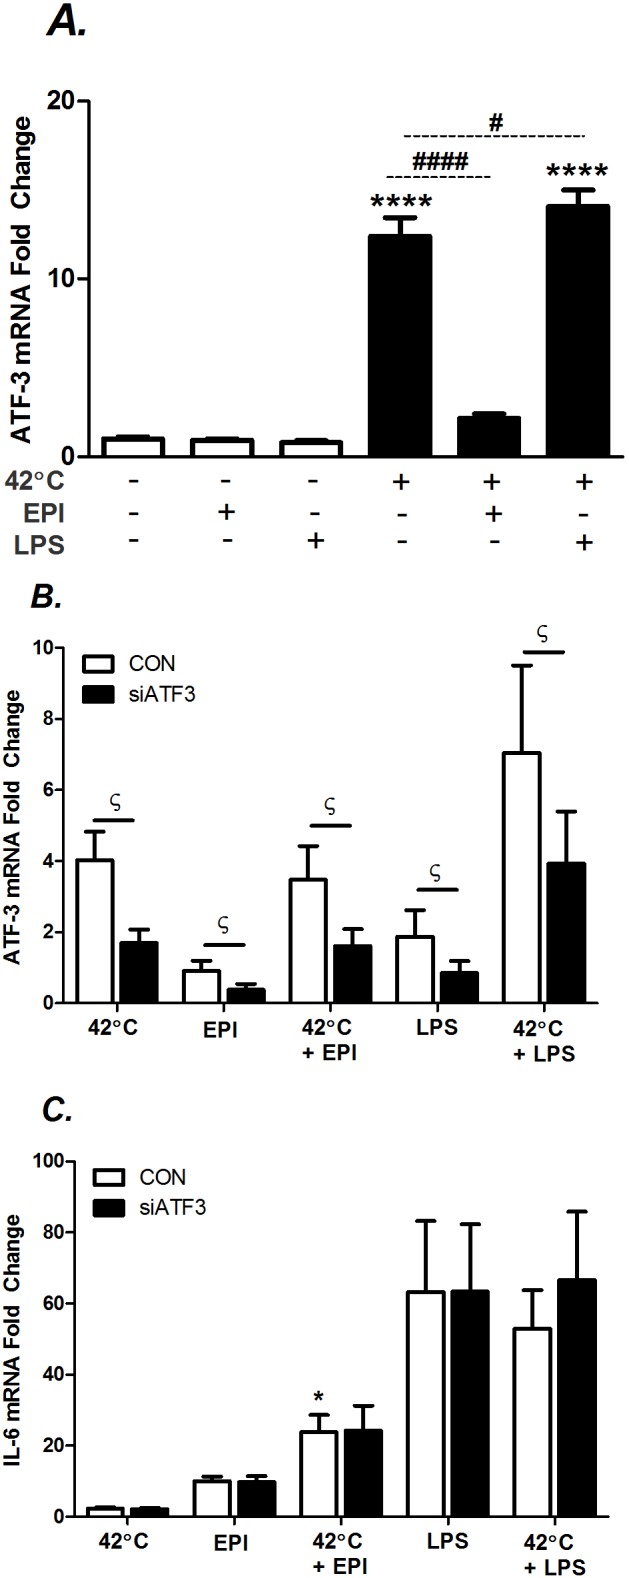
Effects of ATF-3 on IL-6 regulation in heat shocked myotubes.A) Myotubes were maintained at 37°C 3 h or 42°C 1 h and 37°C 2 h. Select cultures were co-stimulated with EPI (100 ng/ml) or LPS (1 μg/ml). B and C) Myoblasts were transfected with siATF-3 or with the control (CON), scrambled nucleotides. Next, myoblasts subsequently underwent the same treatment described in A. Cells were harvested and mRNA expression was determined by real-time qRT-PCR. Results from multiple cultures, three independent experiments, two-to-three samples per experiment; statistical tests were post-ANOVA least squares contrasts between means. * Comparison during matching experimental treatments 37 vs. 42°C; # comparison vs. 42°C; ϛ comparison vs. mismatched scramble (CON); * ϛ (P<0.05), ** (P<0.01) and **** or #### (P<0.0001).